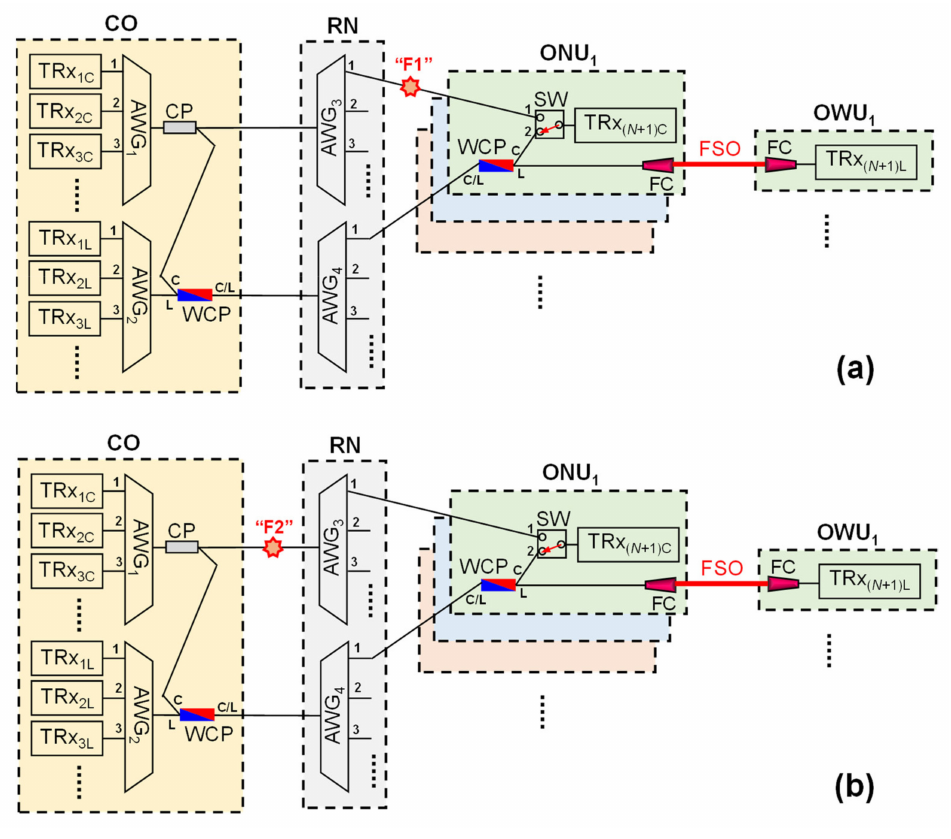
Figure 3. The occurrence of fiber fault at the ( a ) “F1” and ( b ) “F2” points in the presented WDM-PON system, respectively.